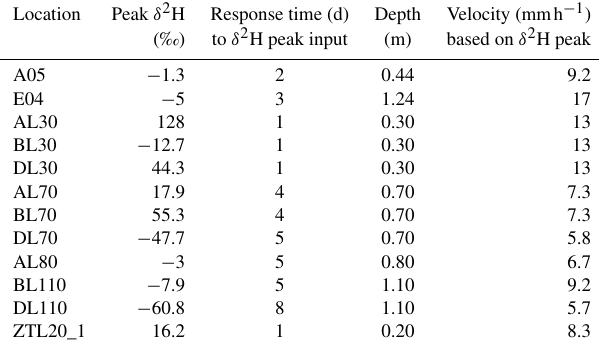
Table 2. Calculated velocities based on timing of δ 2 H peak and mean arrival time of δ 2 H (first normalized moment of the break- through